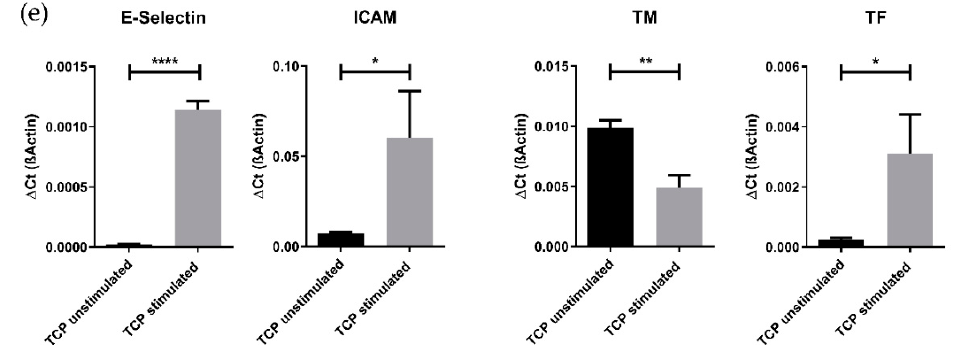
Figure 1. Characterization of isolated pCECs. ( a ) Histogram view of cultured pCECs, analyzed via flow cytometry for the expression of CD31 (red) versus the IgG control (blue); ( b ) Calcein staining (green) of the confluent and viable pCECs monolayer on TCP with a characteristic cobblestone morphology; Immunofluorescence microscopy of pCECs on TCP for the detection of ( c ) the EC- specific junction protein VE-Cadherin (green) and ( d ) the extracellular matrix protein fibronectin (green); ( c , d ) Corresponding nuclei were counterstained with Hoechst 33342 (blue); ( e ) Real-time qRT-PCR expression analysis of inflammatory (E-Selectin and ICAM) and thrombogenic state (TM and TF) marker genes with and without TNF α stimulation. Gene expression levels of the stimulated group were compared to its respective unstimulated control group using an unpaired t -test. TCP: Tissue Culture Plastic; stimulated: six hours TNF α exposure; unstimulated: control group without TNF α exposure. Results are given as mean with SD ( n = 3) (* p < 0.05; ** p < 0.01; **** p < 0.0001).